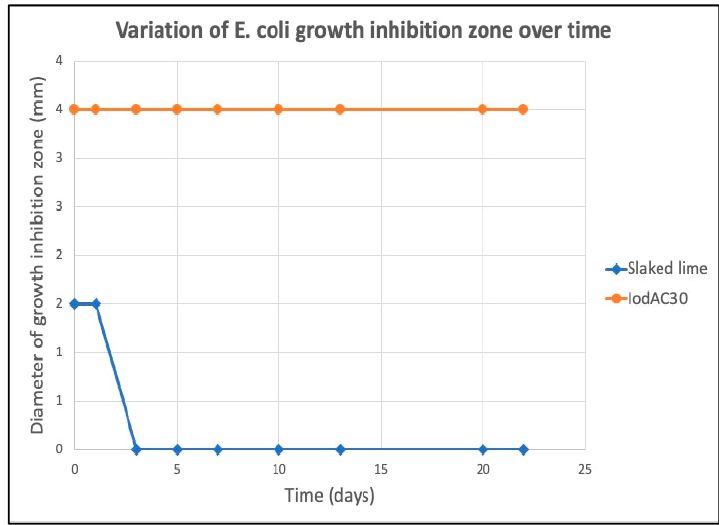
Figure 11. IodAC vs. slaked lime: variation of antibacterial effectiveness.